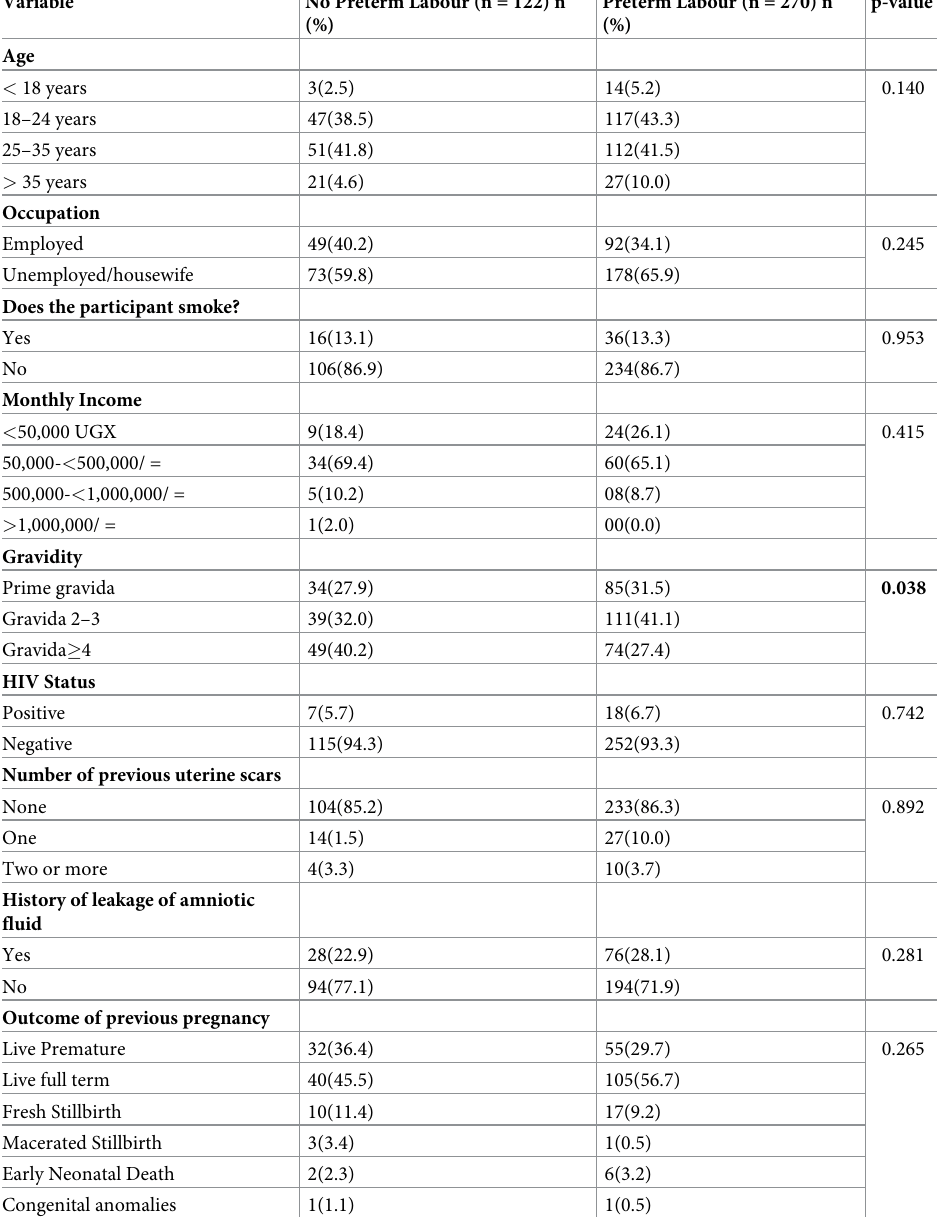
Table 1. Baseline and obstetric characteristics of 392 women admitted between 24 to 28 weeks of gestation at Kawempe National Referral Hospital, Kampala, Uganda.